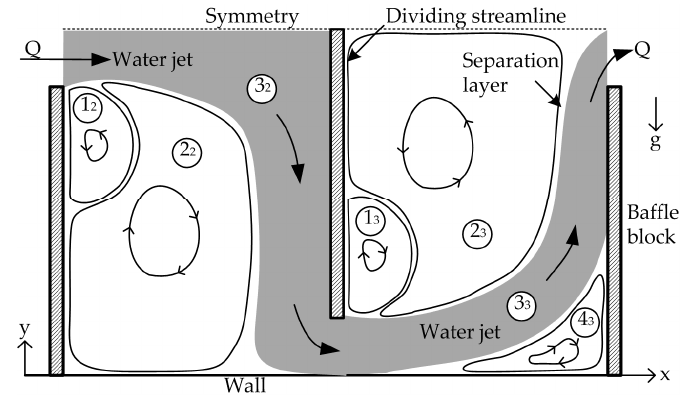
Figure 8. Schematic identification of different flow zones in two adjacent chambers.